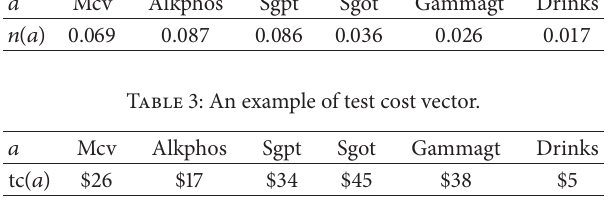
Table 2: An example of neighborhood boundary vector. 𝑎